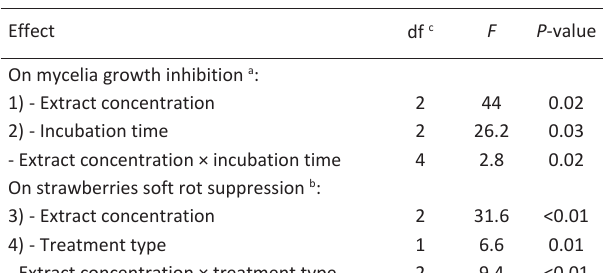
Table 1 - Synthetic values to different two-way ANOVA analysis to Rhizopus stolonifer mycelia growth inhibition and strawberries Rhizopus soft rot suppression at P-value